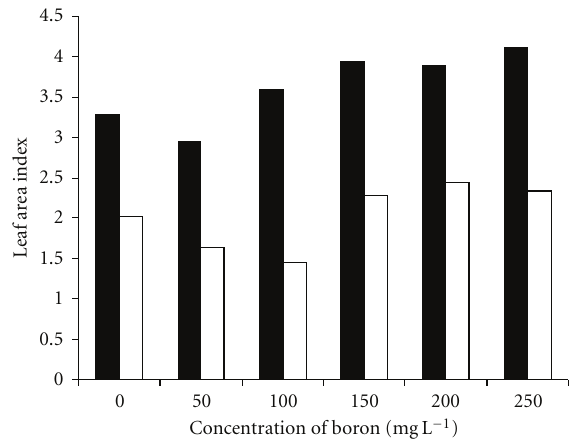
Figure 3: E ff ect of foliar applied boron on number of seed in head in spring (filled columns) and autumn (open columns) sunflower crops. (LSD 0 . 05 124 and 174, resp.).